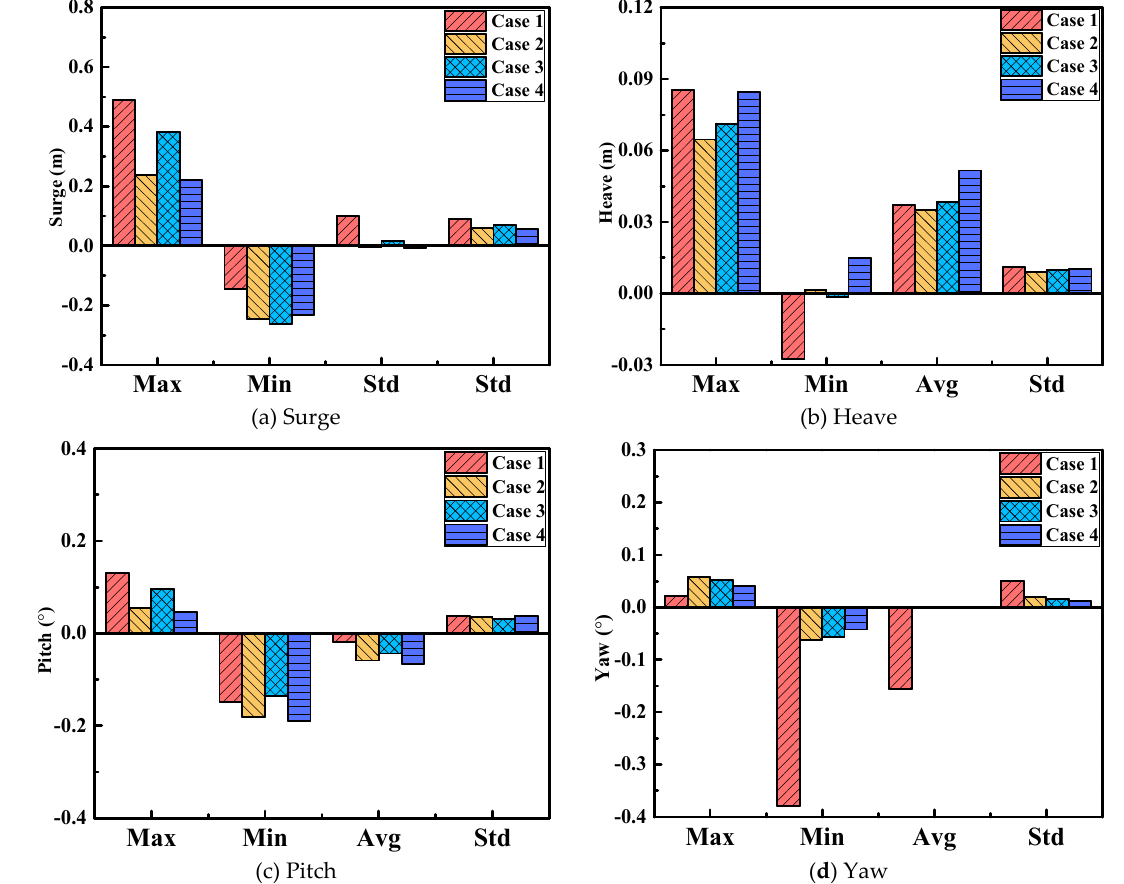
Figure 22. Motion statistics of the platform with broken mooring lines.